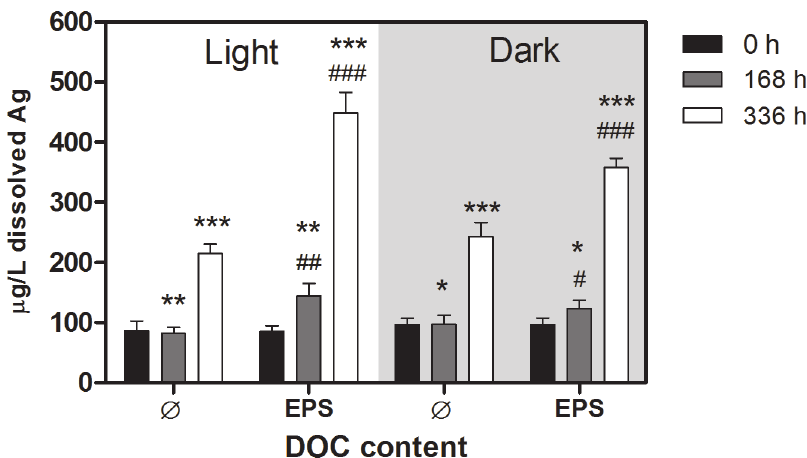
Figure 6. Mean mass concentrations with standard deviations of dissolved Ag in 5 mg/L Ag NP dispersions directly after addition of NP (,,0 h’’) and after 168 h and 336 h of incubation as determined by ICP-MS of acid-digested samples. Samples were incubated in the dark or in light (100 m E/m 2 s). n=9 from 3 independent experiments, each experiment was done with one EPS extract (10 mg DOC/L). * Significant difference between EPS-free and EPS containing samples; # significant difference between light and dark treated samples, 168 h: p=0.0012, df=3 (between groups), F=5.774, 336 h: p , 0.0001, df=3 (between groups), F=66.56.